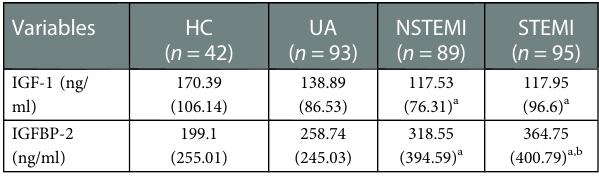
TABLE 1 Plasma levels of IGF-1 and IGFBP-2 in studied population. Variables